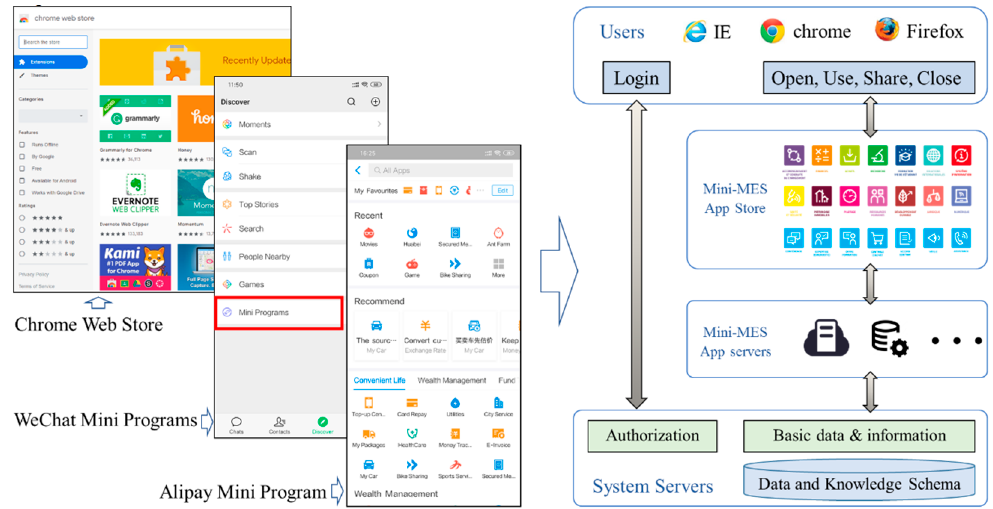
Figure 1. The architecture of the M 2 ES Apps System.